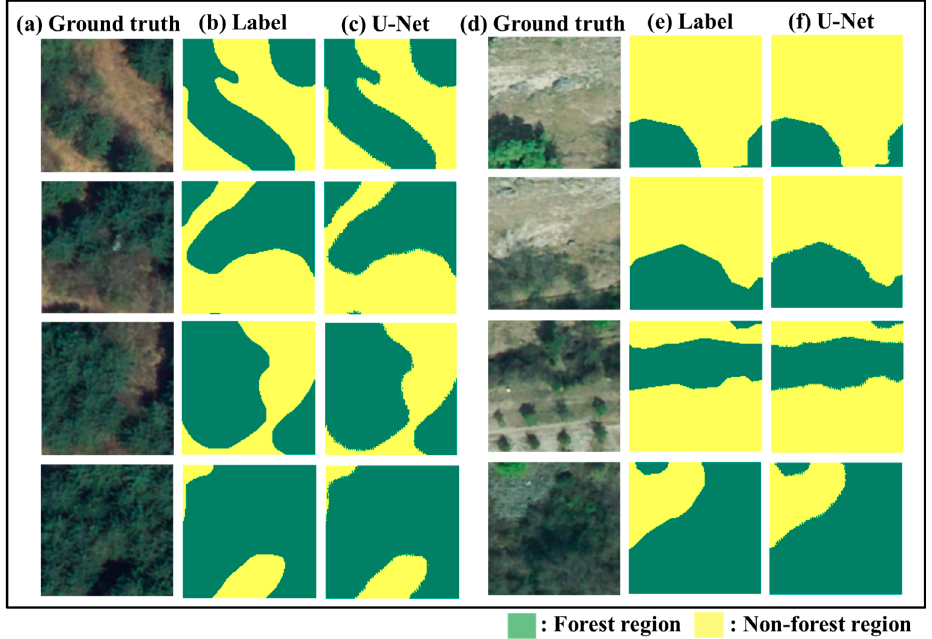
Figure 5. U-Net training results classifying forest and non-forest regions at 1500 epoch. ( a , d ) indicate the RGB images of ground truth in the segmented area, ( b , e ) present label images of forest and non- forest region denoting to 0 and 1, respectively, and ( c , f ) are the forest classification results of U-Net in each image pixel. Green color denotes the forest area while yellow indicates non-forest area.